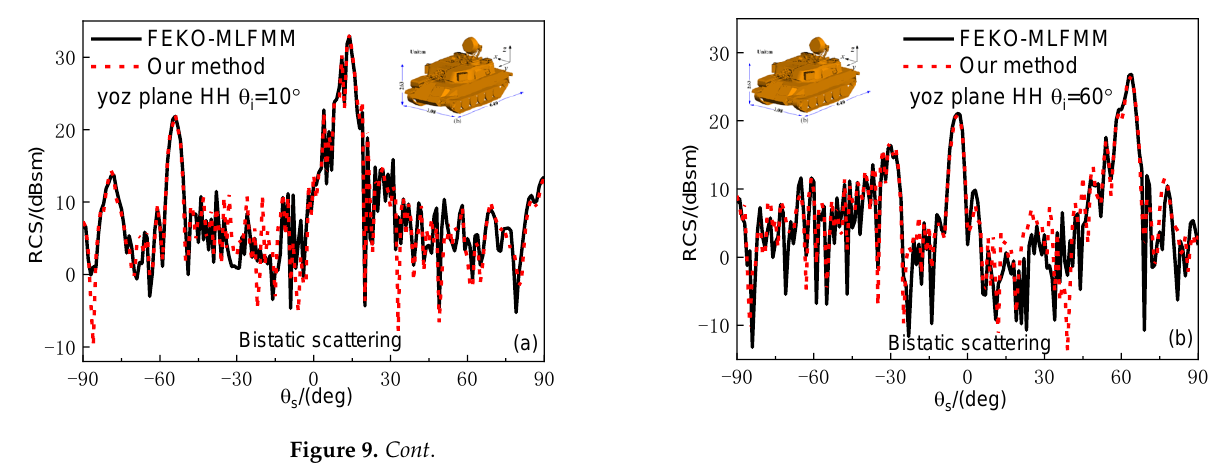
Figure 8. ZSU-234 antiaircraft gun ( a ) optical image; ( b ) CAD model.